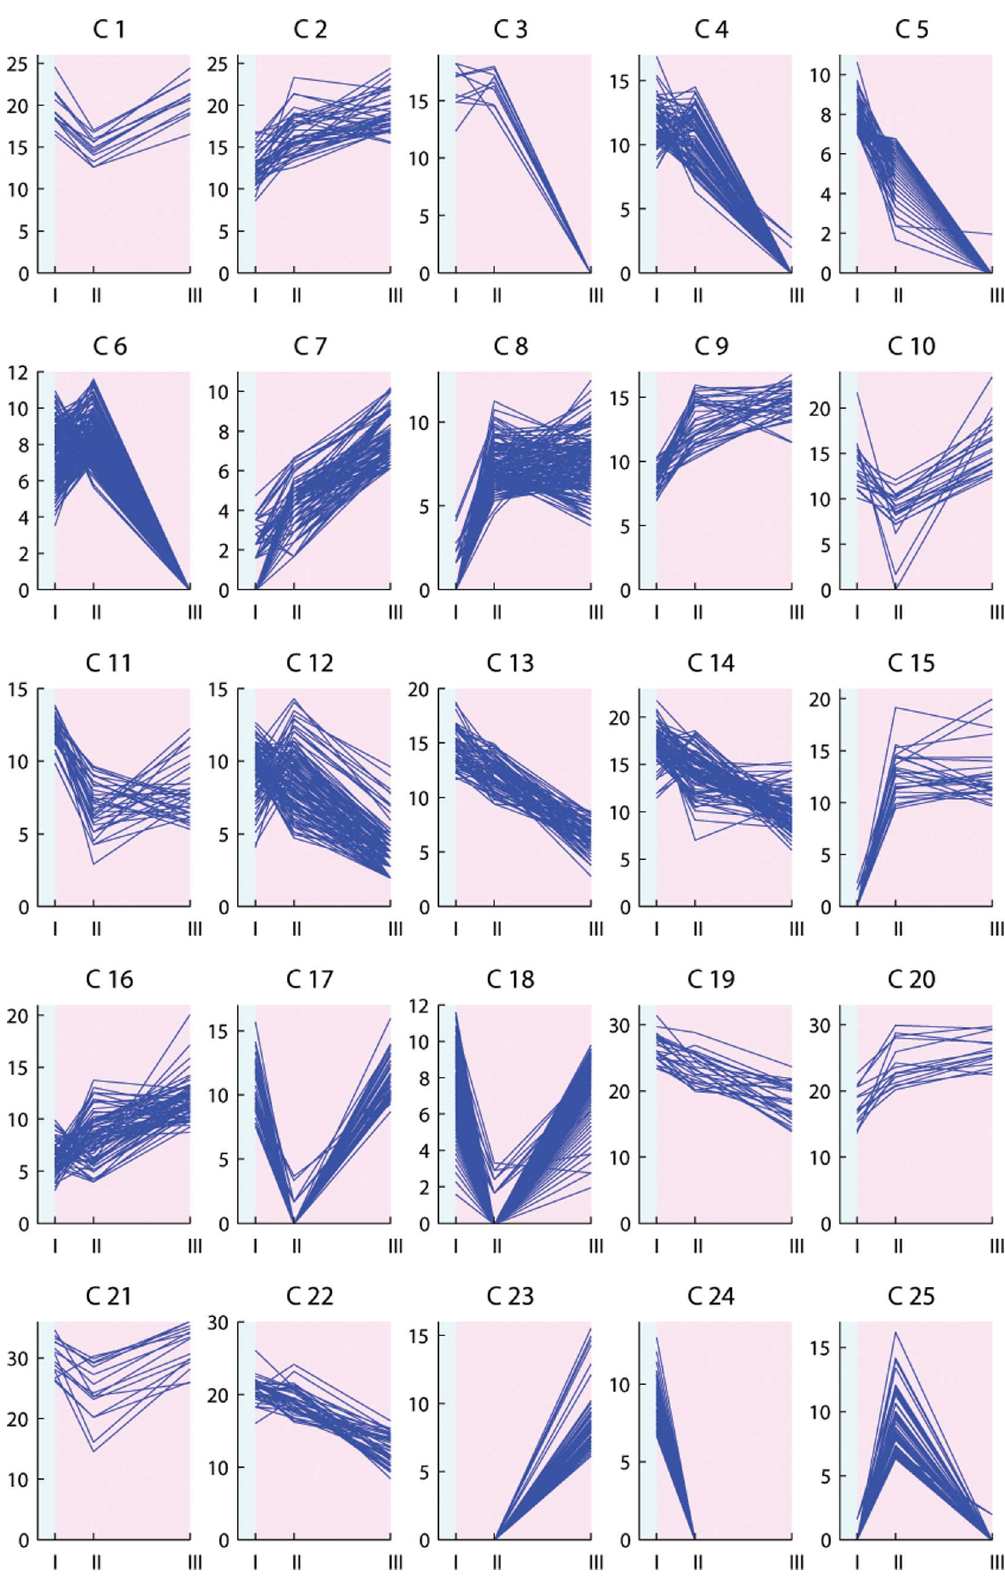
Figure 5. K-means clustering analysis of transcripts differentially expressed in Falster enriched meristem samples. K=25 clusters. The x axis presents the sample collection time points: I=9 weeks of vernalization; II=1 long day; III=7 days of long day conditions. The y axis corresponds to the variance stabilized data from DESeq. The blue background illustrates vernalization treatment, the pink background illustrates long day conditions. doi:10.1371/journal.pone.0107365.g005 PLOS ONE |